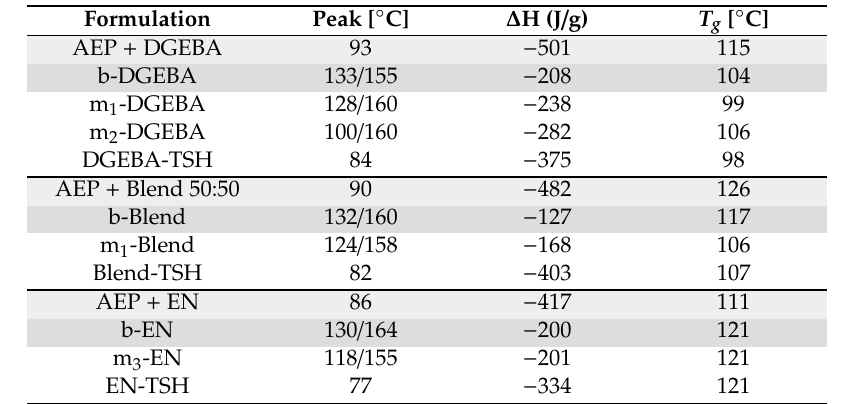
Table 2. Overview of samples and its corresponding temperature of highest reaction (peak), the curing enthalpy ∆ H, and the T g (second heating) determined by DSC with a heating ramp of − 30...300 ◦ C at 10 ◦ C / min and 50 mL N 2 /